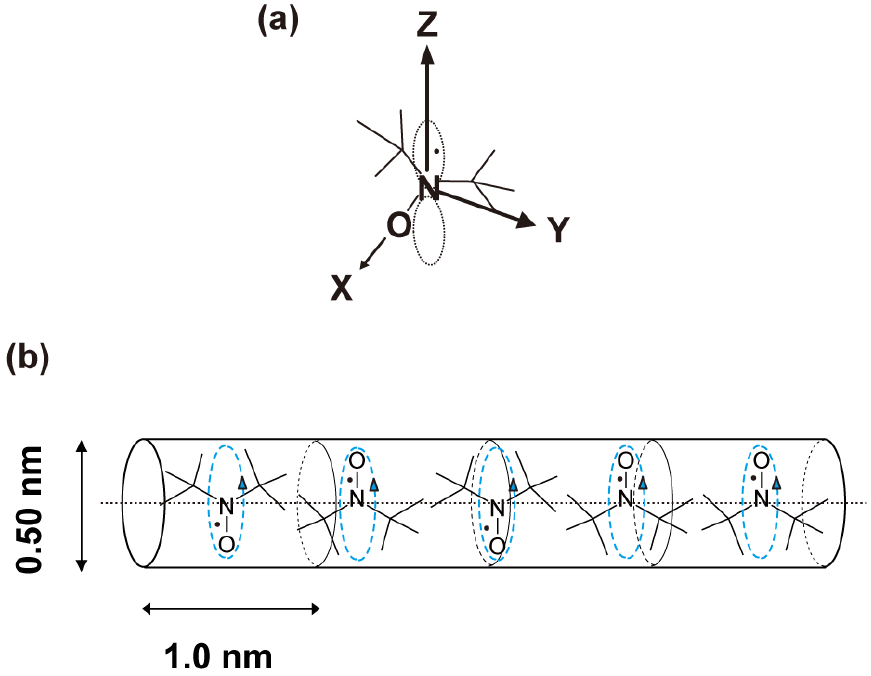
Figure 2. Molecular axes of DBNO (a) and the packing model of DBNO molecules in the TPP nanochannels (b) . According to the composition of 1 determined by CA, TG, and spin concentration measured by ESR, it is expected that 1.25 DBNO molecules are accommodated in the TPP unit cell formed by two TPP molecules, i.e. , five DBNO molecules are included in four TPP unit cells. In Figure 2(b), all DBNO molecules are depicted only in the upward or downward form for reasons of expediency, although in fact, the orientation of their nitroxide groups are expected to be disordered in a vertical plane to the channel axis of the TPP nanochannels. The cyan dashed curly arrows represent the uni- axial rotation of DBNO molecules around the channel